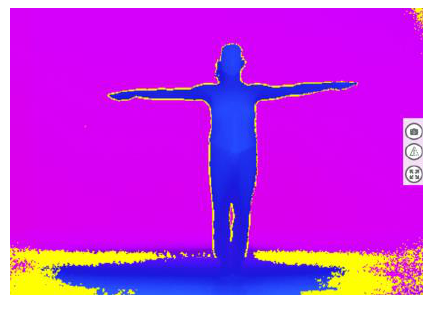
Figure 11. T- Pose in iPi Recorder